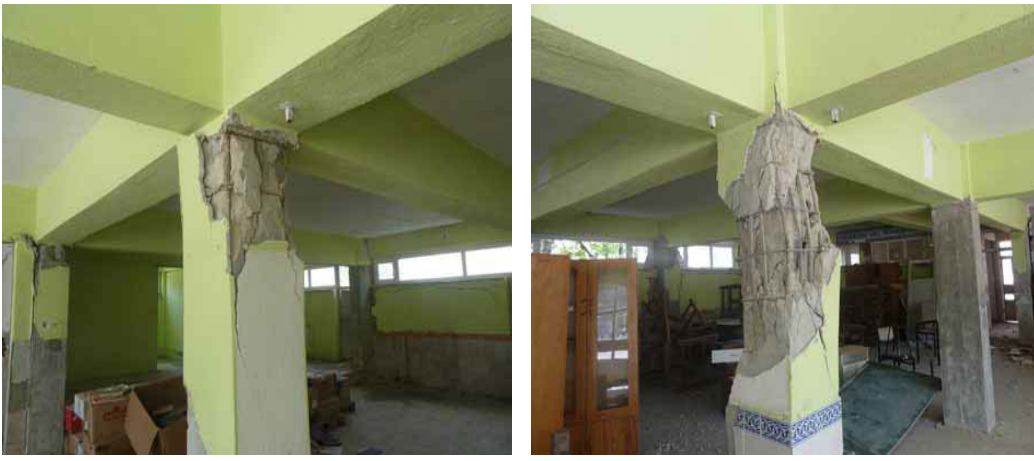
Figure 9. The failure of strong beam-weak column.